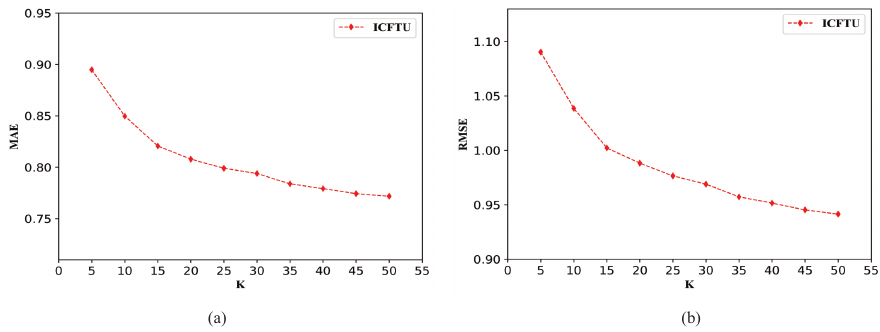
Figure 6. The influence of K on the proposed method: ( a ) of MAE; ( b ) of RMSE.